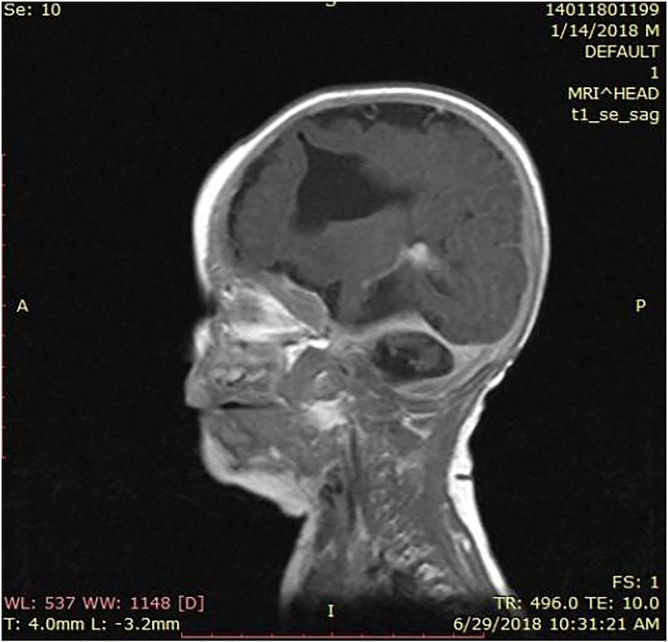
MRI scan, sagittal view, evaluating the hypoplasia of the pons and cerebellum.